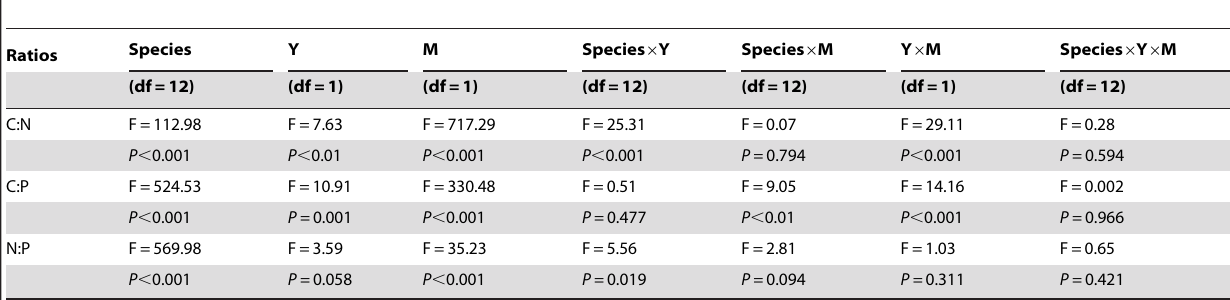
Table 3. Multivariate ANOVA results for the effects of species, sampling year (Y) and sampling month (M) on leaf C:N, C:P, N:P ratios in the field study.